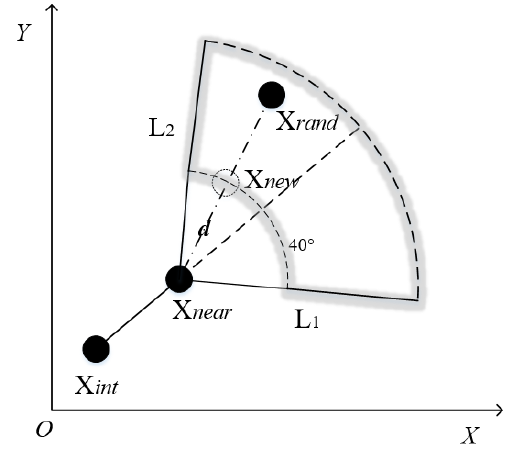
Figure 5. Extended schematic.